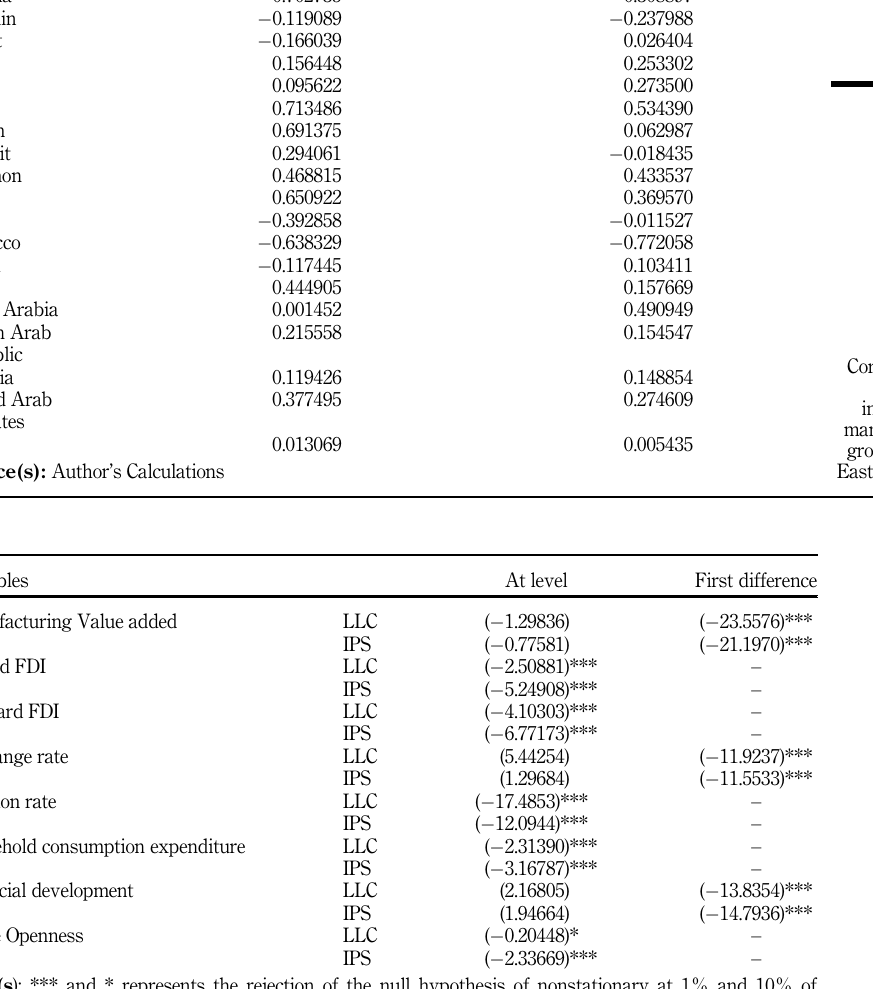
Table 2. Panel unit root